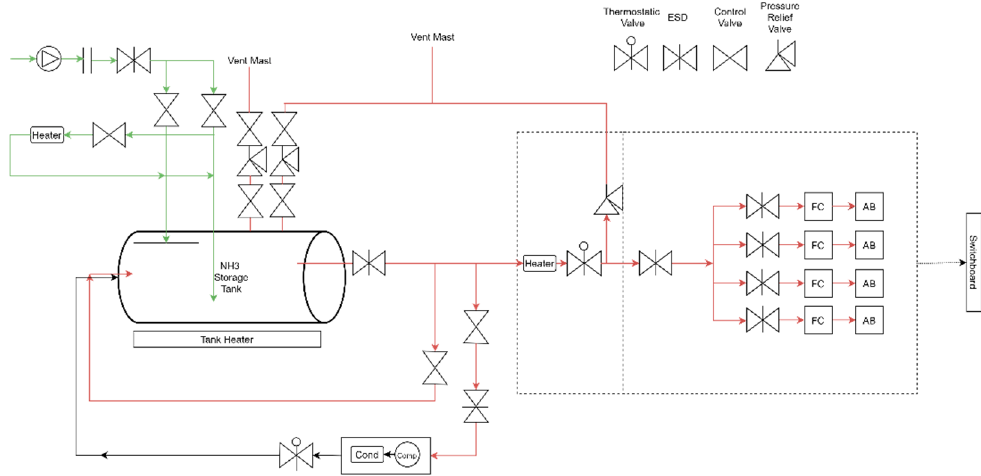
Figure 3. Line diagram of the system considered.